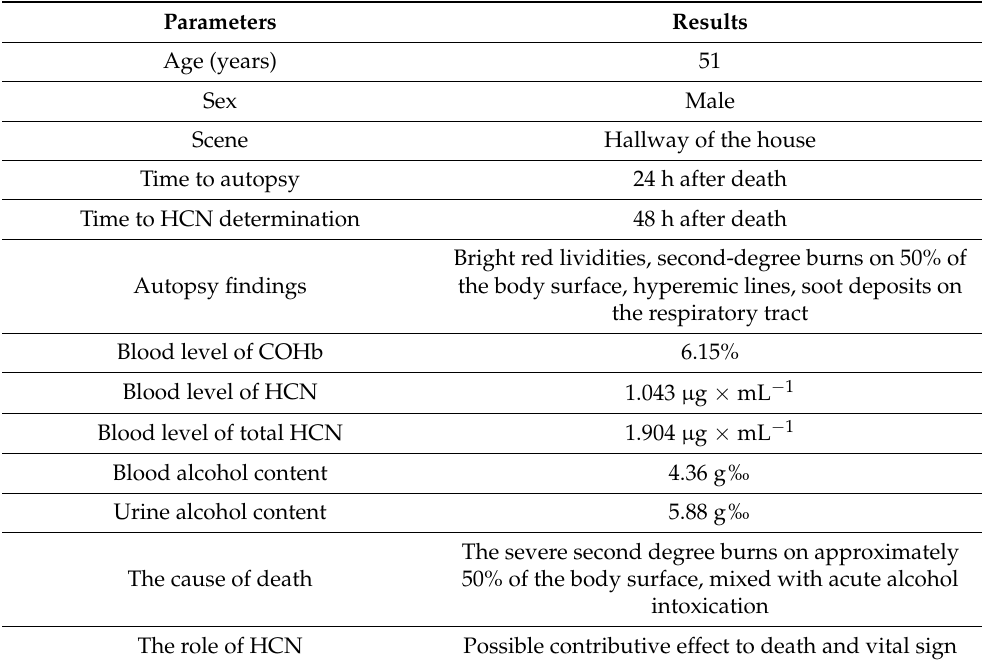
Table 1. The main results of the presented